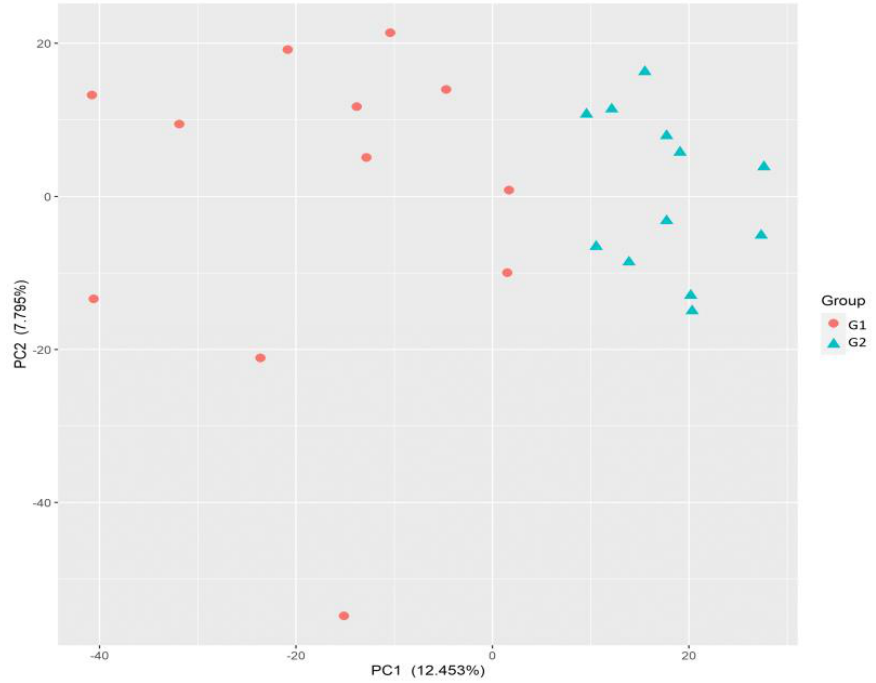
Figure 2. Principal component (PC) analysis performed based on normalized count data of gene ex- pression for samples collected at weaning from G1 (control, no creep feeding) and G2 (creep